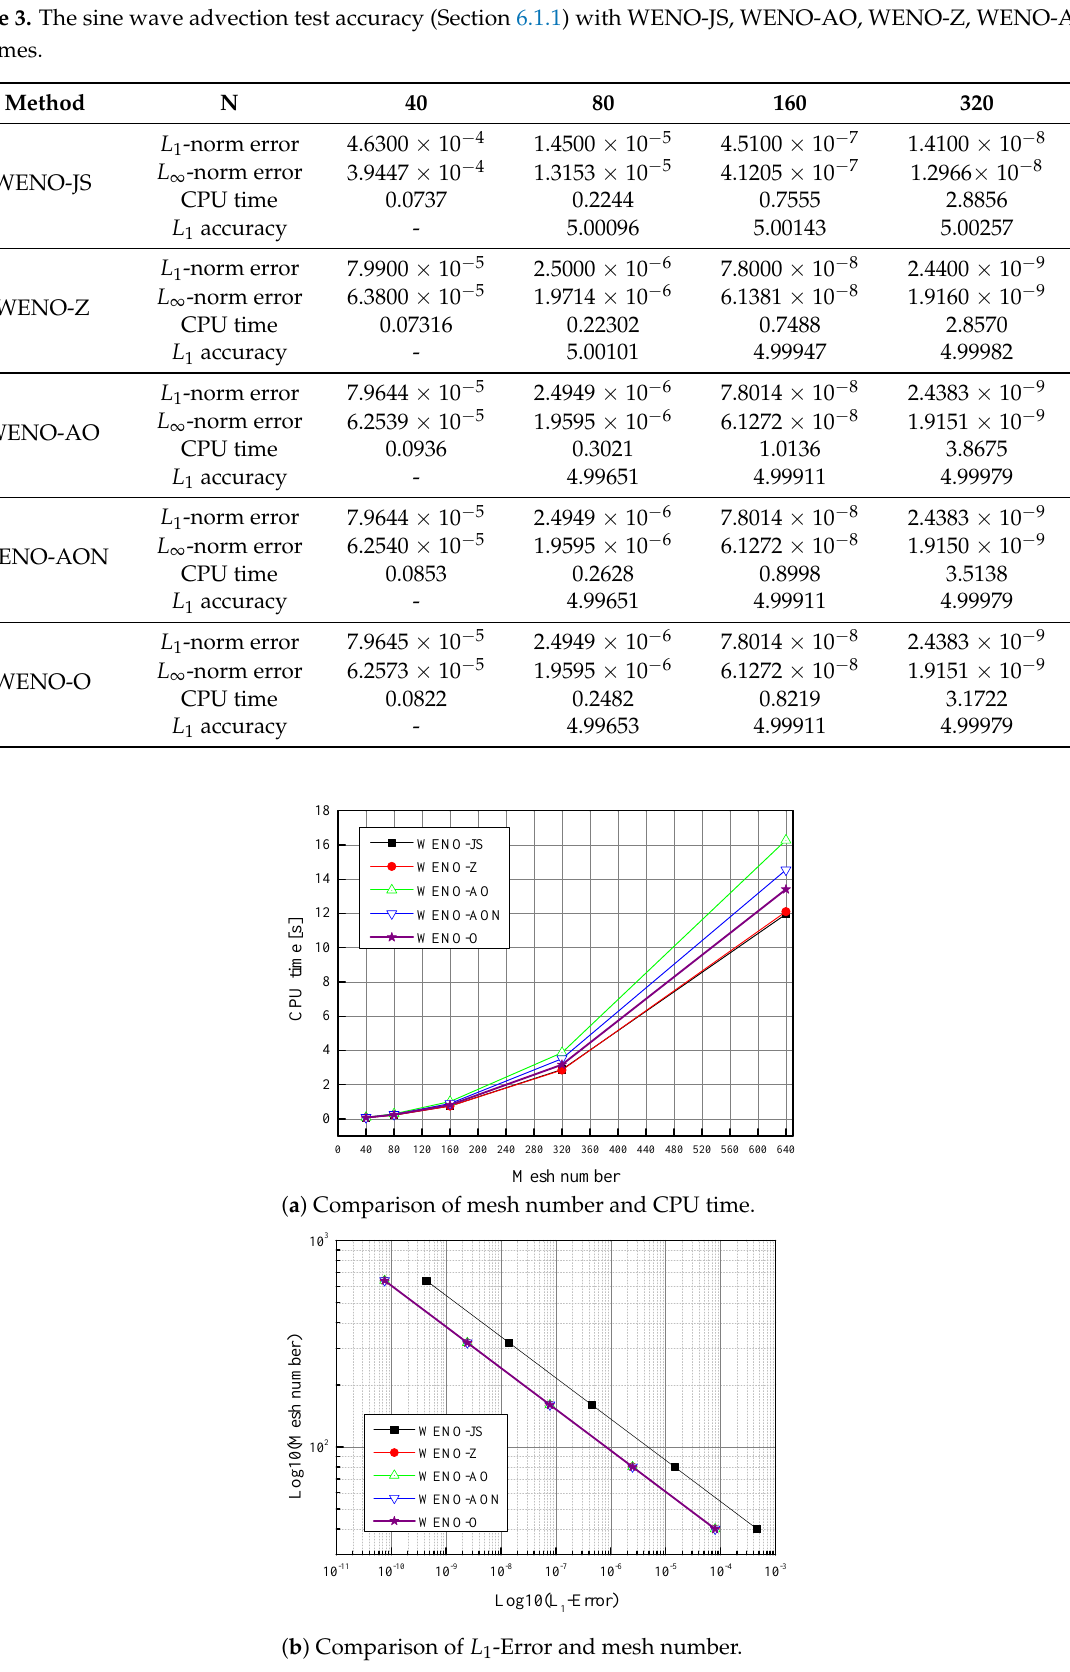
Figure 3. The performance comparison of WENO-O with WENO-AO, WENO-AON, WENO-Z, and WENO-JS schemes for Example 1 (Section 6.1.1) on different number of mesh points at t = 10 and CFL = ( ∆ x ) 2/3